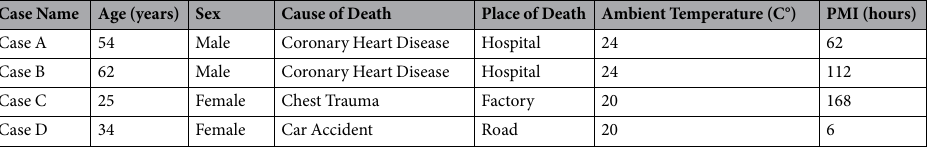
Table 5. Basic information of each corpse used for PMI classification.